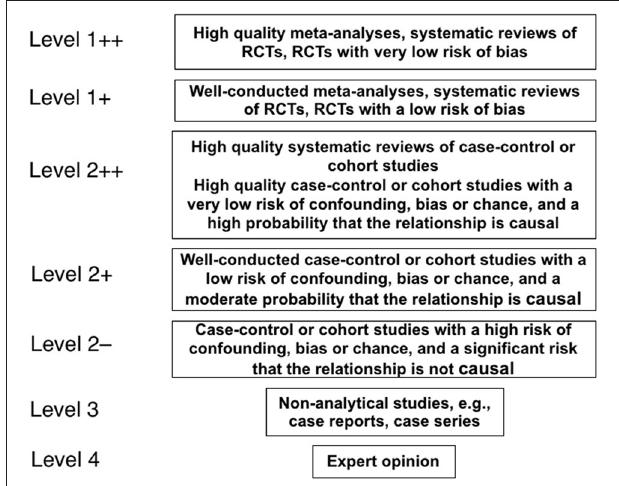
FIGURE 2 | The hierarchy of quality of evidence used in science to evaluate claims, as specified by the Scottish Intercollegiate Guidelines Network